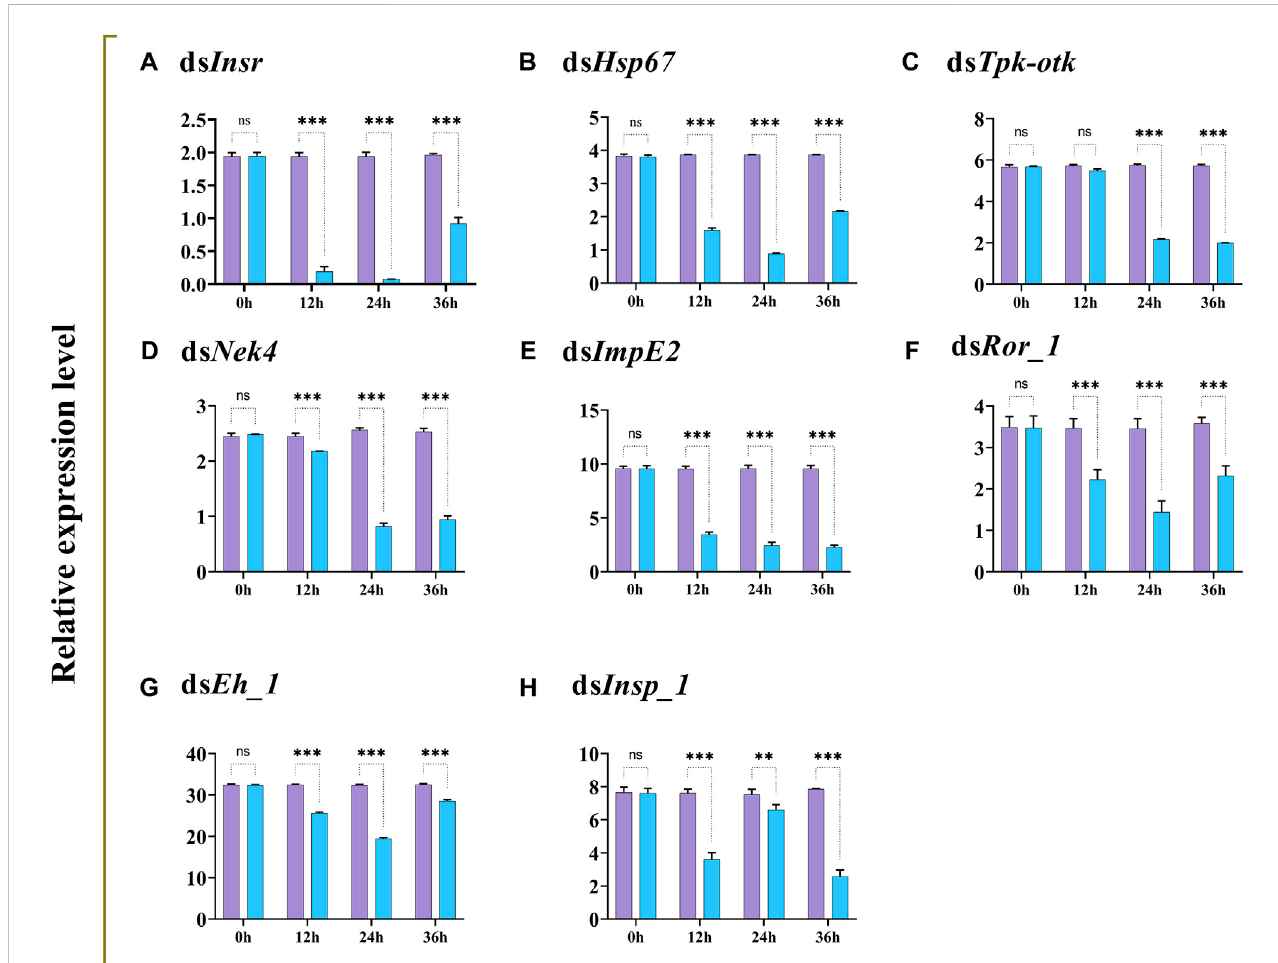
FIGURE 3 Relative expression pro fi les (mean ± SD; N = 3 replicates per treatment) of Insr , Hsp67 , Tpk-tok , Nek4 , ImpE2 , Ror_1 , Eh_1 and Insp_1 in Z. cucurbitae larvae at different times after feeding on gene-speci fi c dsRNA (treatment; blue) compared to dsGFP (control; purple). * p < .05 ; ** p < .01 ; *** p < .001 ; ns, no signi fi cant difference. EF α 1 and Actin were used as internal controls and the 2 − ΔΔ CT method was used to calculate the gene relative expression